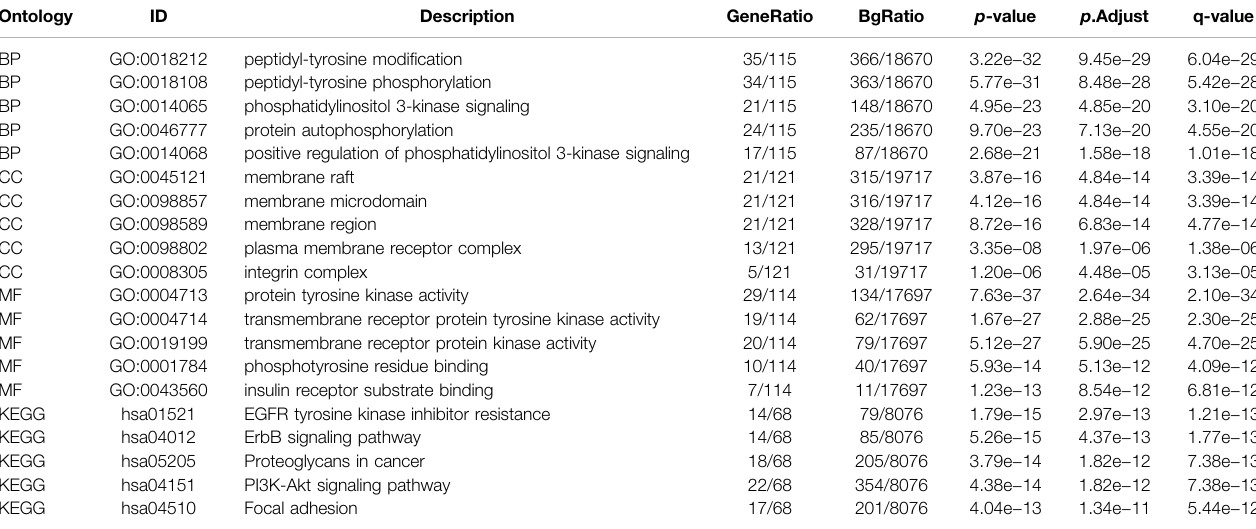
TABLE 5 | Results of GO-KEGG enrichment analysis.